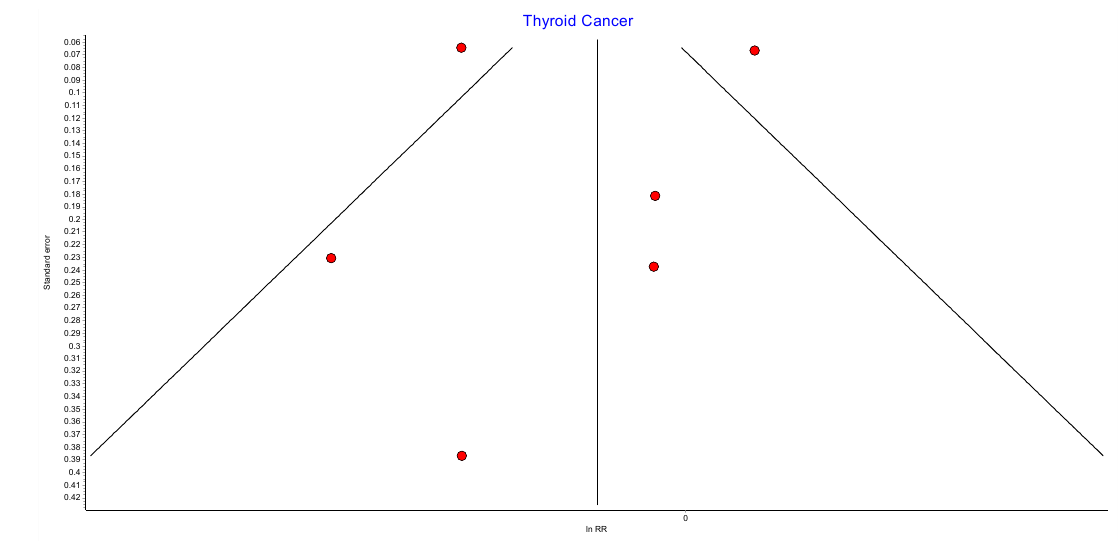
Figure A18. Thyroid cancer random effects model funnel plot.